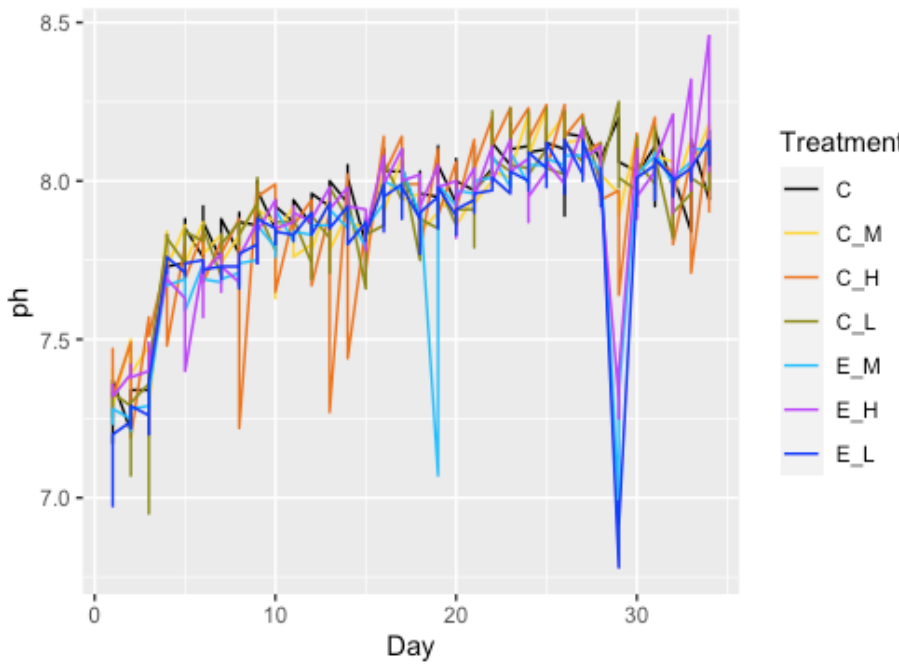
Figure A2. Variation in pH along time between treatments.